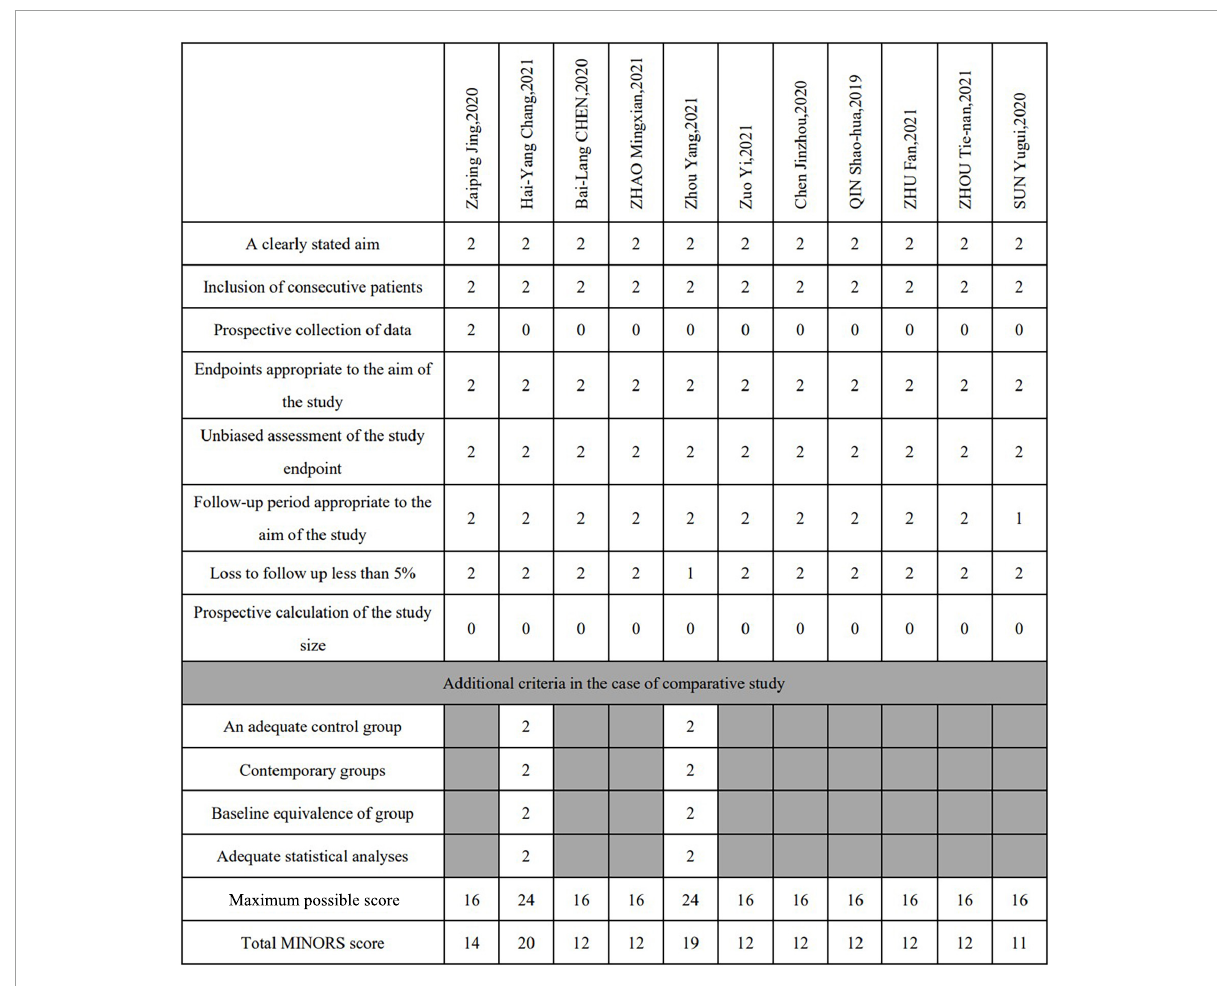
FIGURE2 Study quality assessment (MINORS score). For noncomparative studies the quality was considered poor at a score ≤ 8, moderate at 9–14, and good at 15–16. The cutoff points were ≤ 14, 15–22 and 23–24, respectively, for comparative studies.